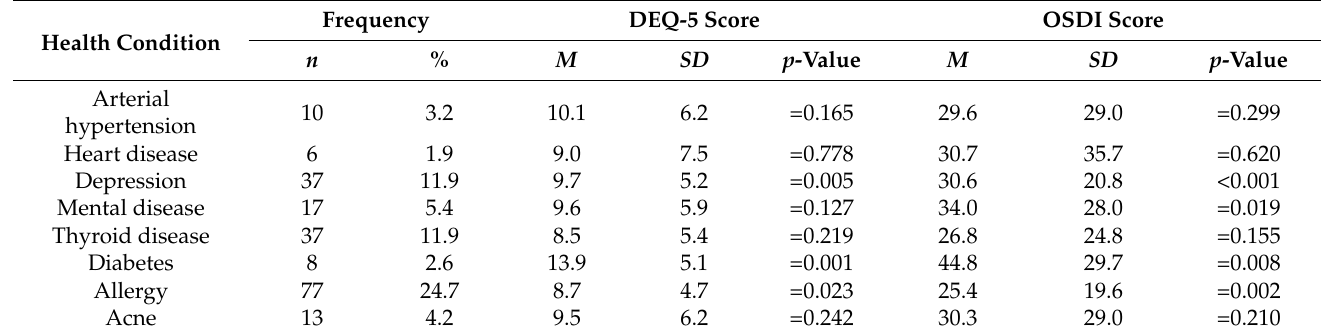
M —mean; SD —standard deviation. Table 3. Comorbidities in the study participants ( n = 312).